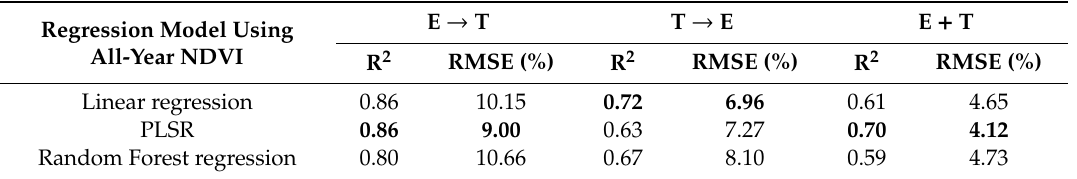
Table 7. R 2 and RMSE of the three all-year NDVI regression methods for the integrated models including Ethiopia and Tanzania. E → T indicates that training data are taken from Ethiopia and tested on Tanzania, while T → E indicates training data from Tanzania tested on Ethiopia (both Scenario 2). E + T indicates that the models are built on the combined data from Ethiopia and Tanzania (Scenario 3). The best performing model per scenario is marked in